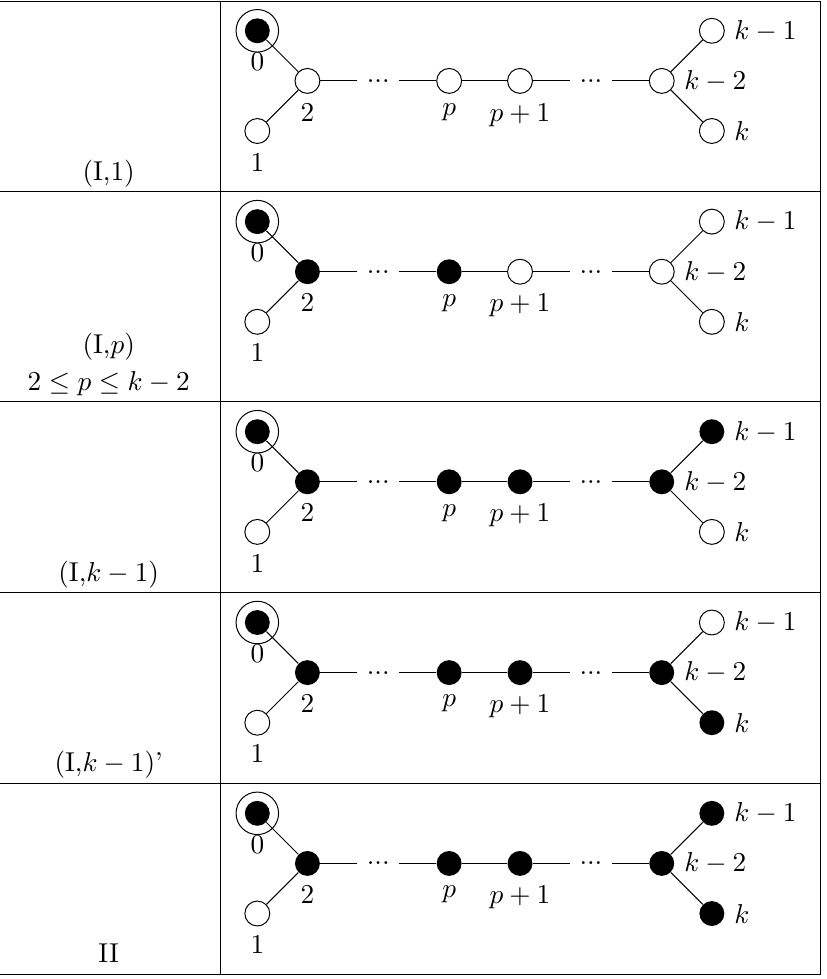
Table 4 . Root system types for so (2 ; 2 k (cid:0) 2) (with k (cid:21) 2). The circled node 0 is the a(cid:14)ne root (cid:12) . The non-circled black nodes are the roots that are orthogonal to (cid:3). Because of the conventions for (cid:3), the root 1 can never be orthogonal to (cid:3).